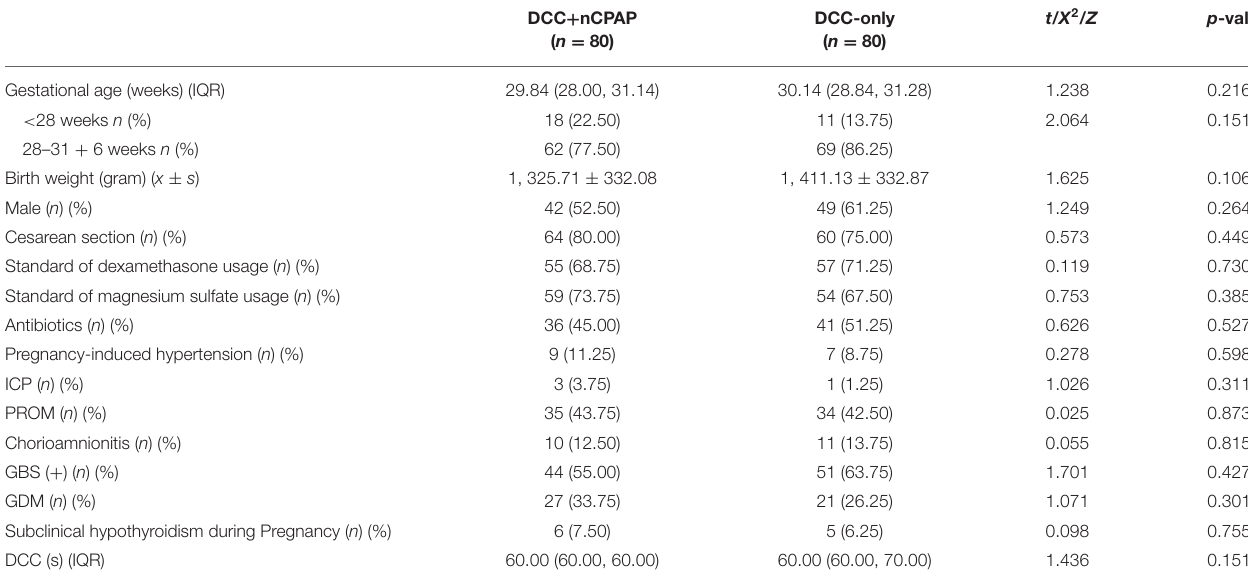
TABLE 1 | Baseline